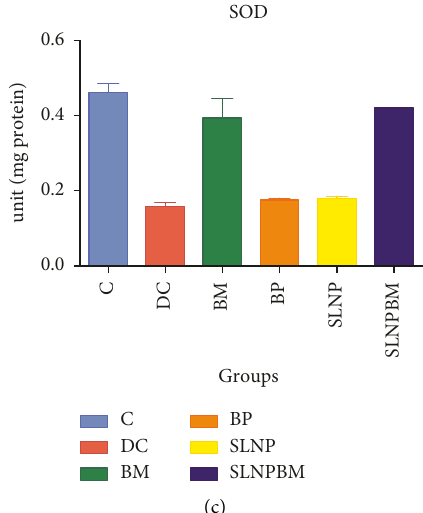
Figure 12: (a) Effect of microneedle on cellular glutathione depletion and glutathione recovery in Wistar albino rats challenged with rotenone. Brain GSH levels were measured. The graph shows the protein present in unit/mg in brain homogenate, the degree of GSH depletion at DC, and the increase of GSH level in BM and SLNPM. Values given are mean ± SEM, with n (3). (b) Effect of microneedle on enzyme catalase depletion in Wistar albino rats challenged with rotenone. The graph shows the degree of reduced CATat DC and increased CAT level in BM and SLNPM. Values given are mean ± SEM, with n (3). (c) Effect of microneedle on superoxide dismutase enzyme depletion in Wistar albino rats challenged with rotenone. The graph shows the degree of reduced SOD at DC and increase of SOD level in BM and SLNPBM. Values given are mean ± SEM, with n